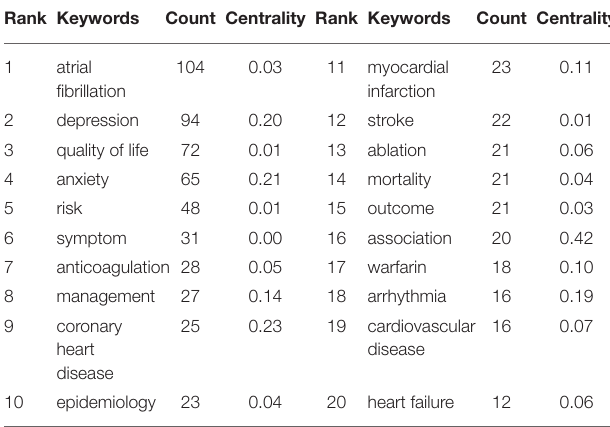
TABLE 4 | Top 20 keywords on atrial fibrillation and